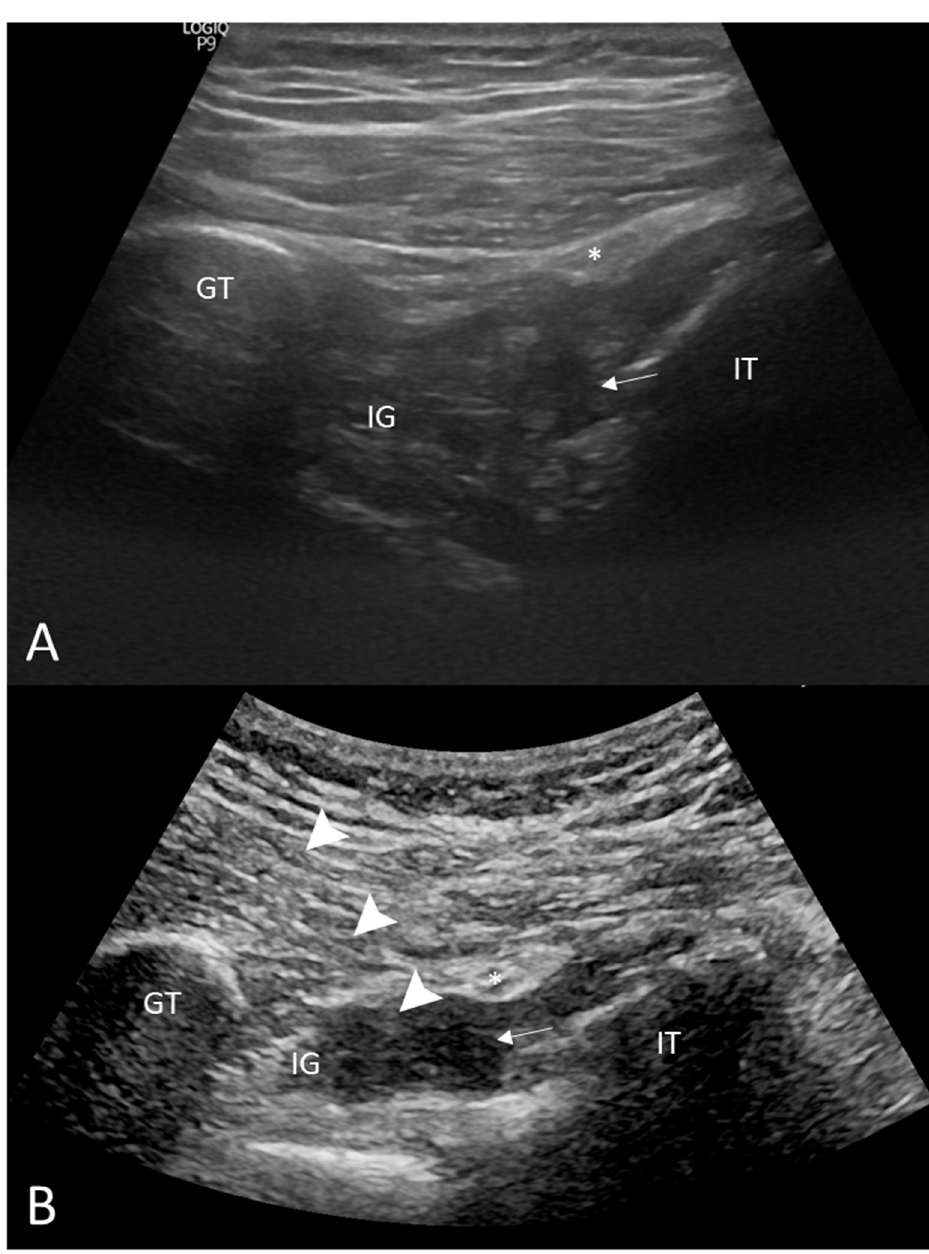
Figure 2. Musculoskeletal sonograph of inferior gemellus. ( A ) Musculoskeletal sonography showed a swollen muscle with hematoma (arrow) between the ischial tuberosity and medial surface of greater trochanter of the femur. Sciatic nerve (asterisk) was superficial to the muscle. The inferior gemellus strain with hematoma was highly suspected before an MRI scan was performed. ( B ) Musculoskeletal sonography showed ultrasound-guided platelet-rich plasma injection (arrowhead) to the inferior gemellus. GT = greater trochanter; IG = inferior gemellus; IT = ischial tuberosity.